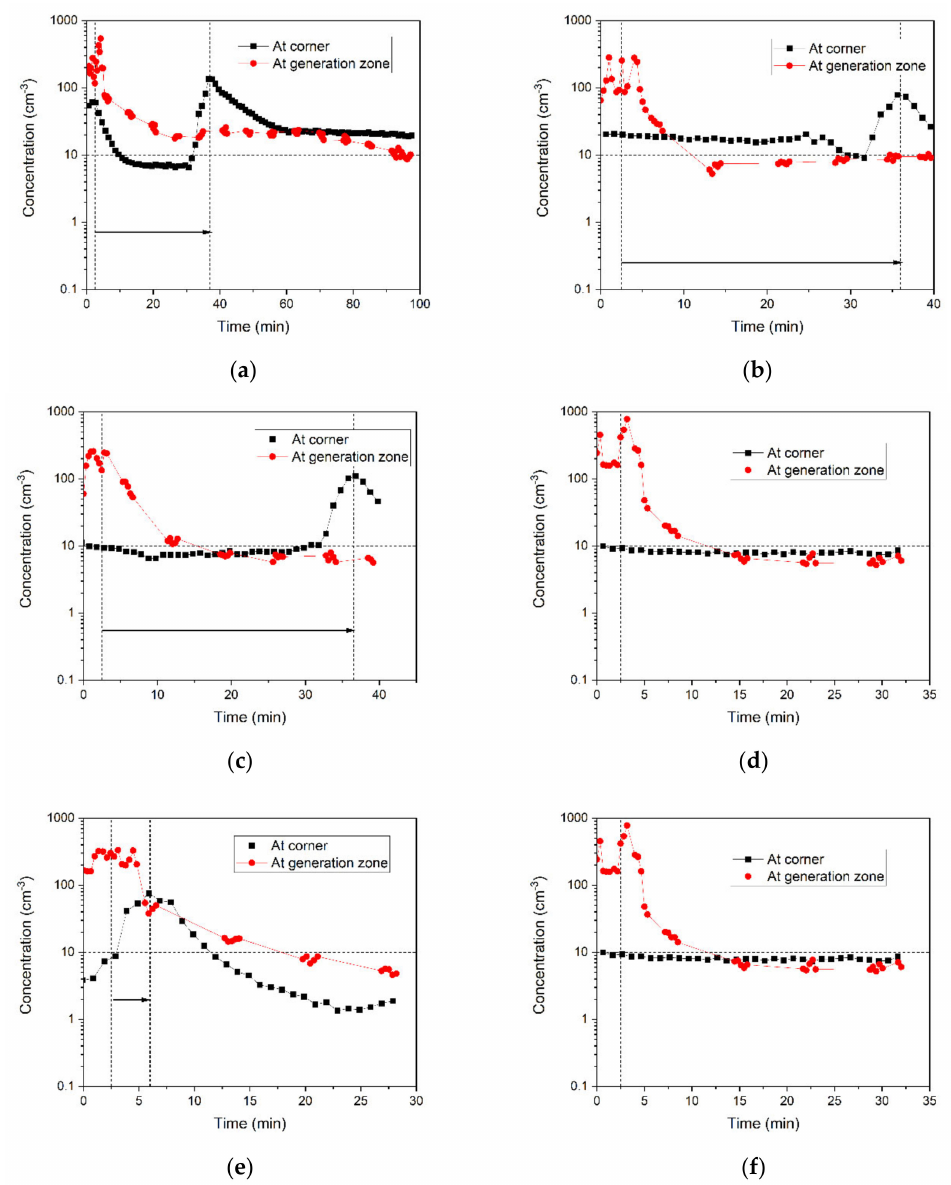
Figure 6. Comparison of the number concentrations of 0.5- µ m particles in the corner with those at the generation zone for ( a – d ) closed-door cases with ( a ) air purifier off, ( b ) low-speed air purifier turned on after particle generation, ( c ) high-speed air purifier turned on after particle generation, and ( d ) high-speed air purifier running from the beginning of particle generation; and ( e , f ) open-door cases with ( e ) air purifier off and ( f ) high-speed air purifier running from the beginning of particle